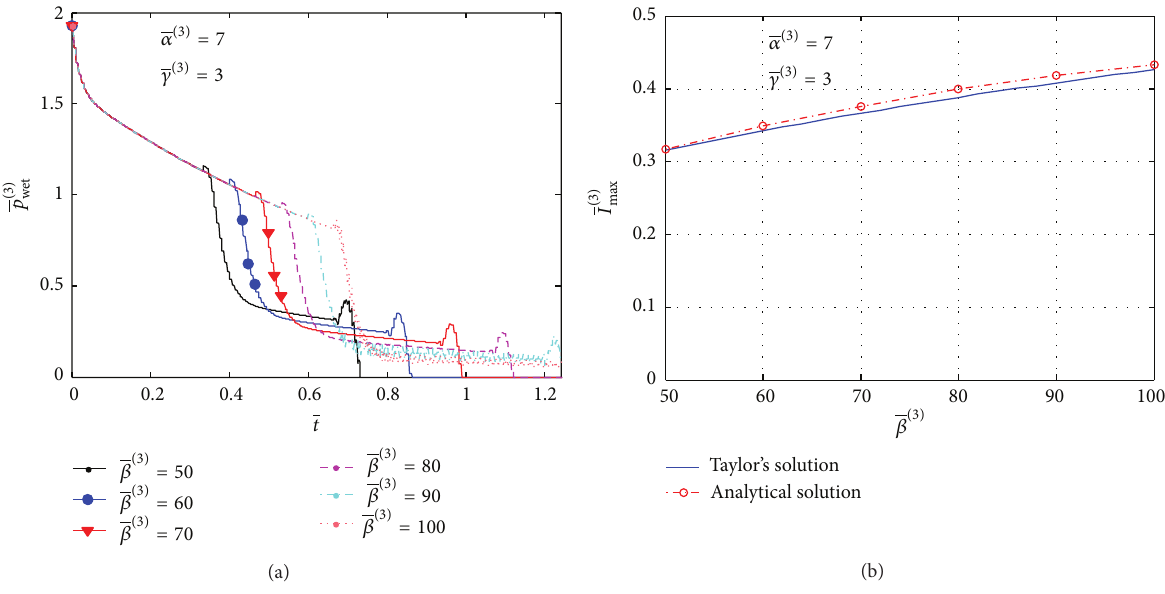
(3) wet for the panel with girder (I-shaped) with the parameter 𝛽 (3) for the panel with girder max to the normalized parameter